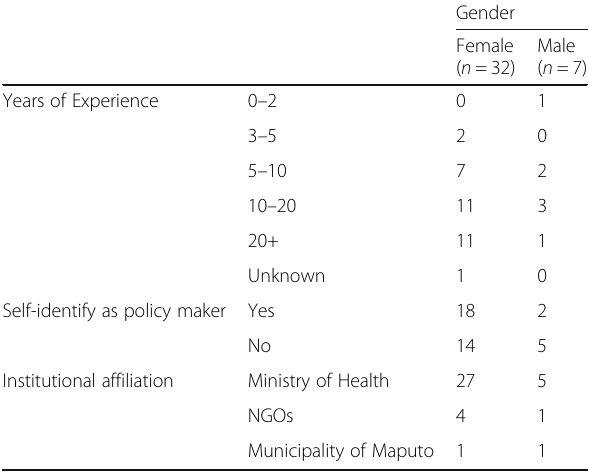
Table 1 Participant